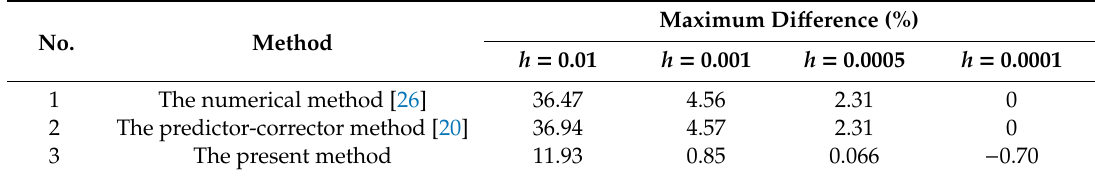
Table 1. The maximum percentage di ff erences for three methods by comparing with the results of the numerical method [26] of h = 0.0001.